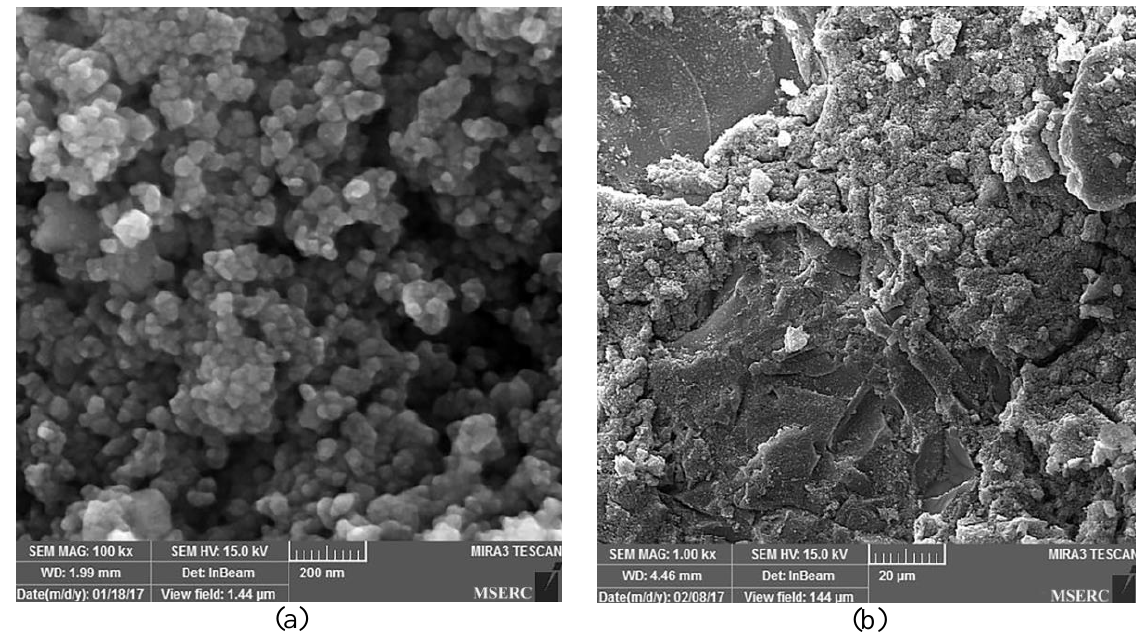
Figure 2. FE-SEM images of (a) TiO